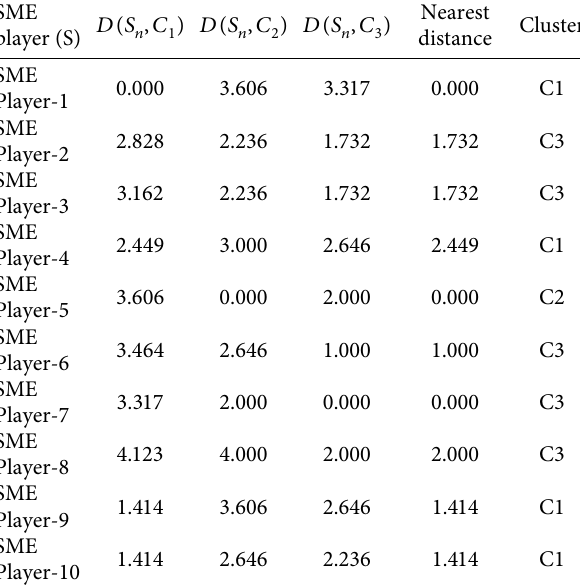
Table 17: Cluster group in first iteration.